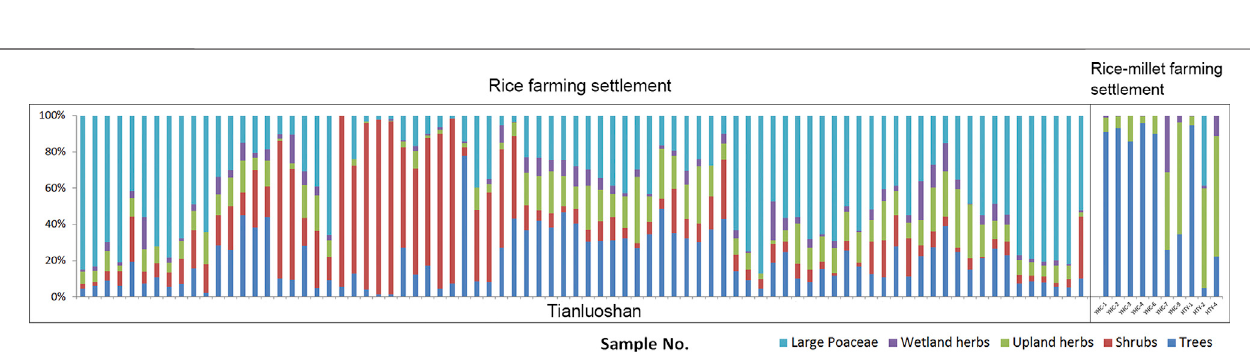
FIGURE 3 | Proportions of pollen groups in the spectrum of the coprolites for this study (note: twenty-one coprolites with extremely high contents of Typha pollen were excluded).